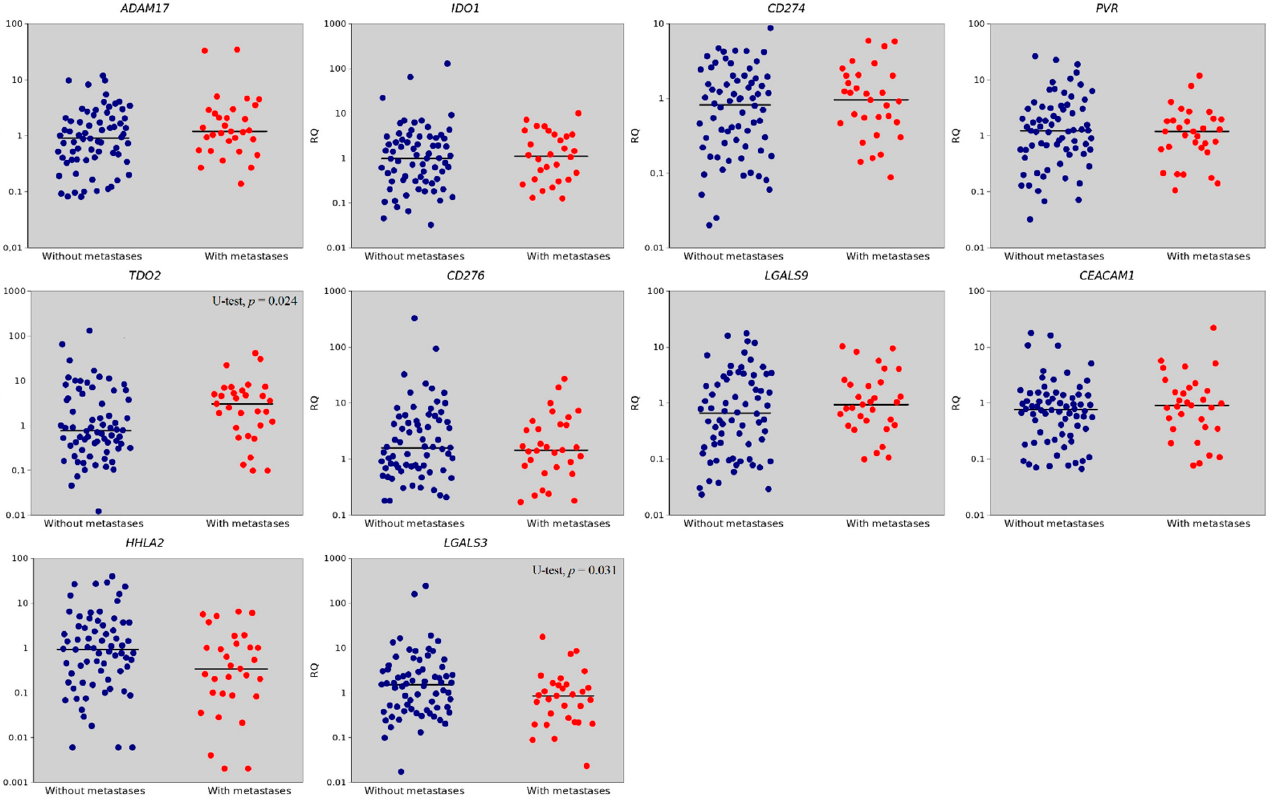
Figure 1. The relative gene expression (RQ) in groups with metastases (red dots) and without metastases (blue dots). Gene expression values are presented on a logarithmic scale. The line marks the median. Table 2. The relationship of gene expression with the development of metastases using ROC